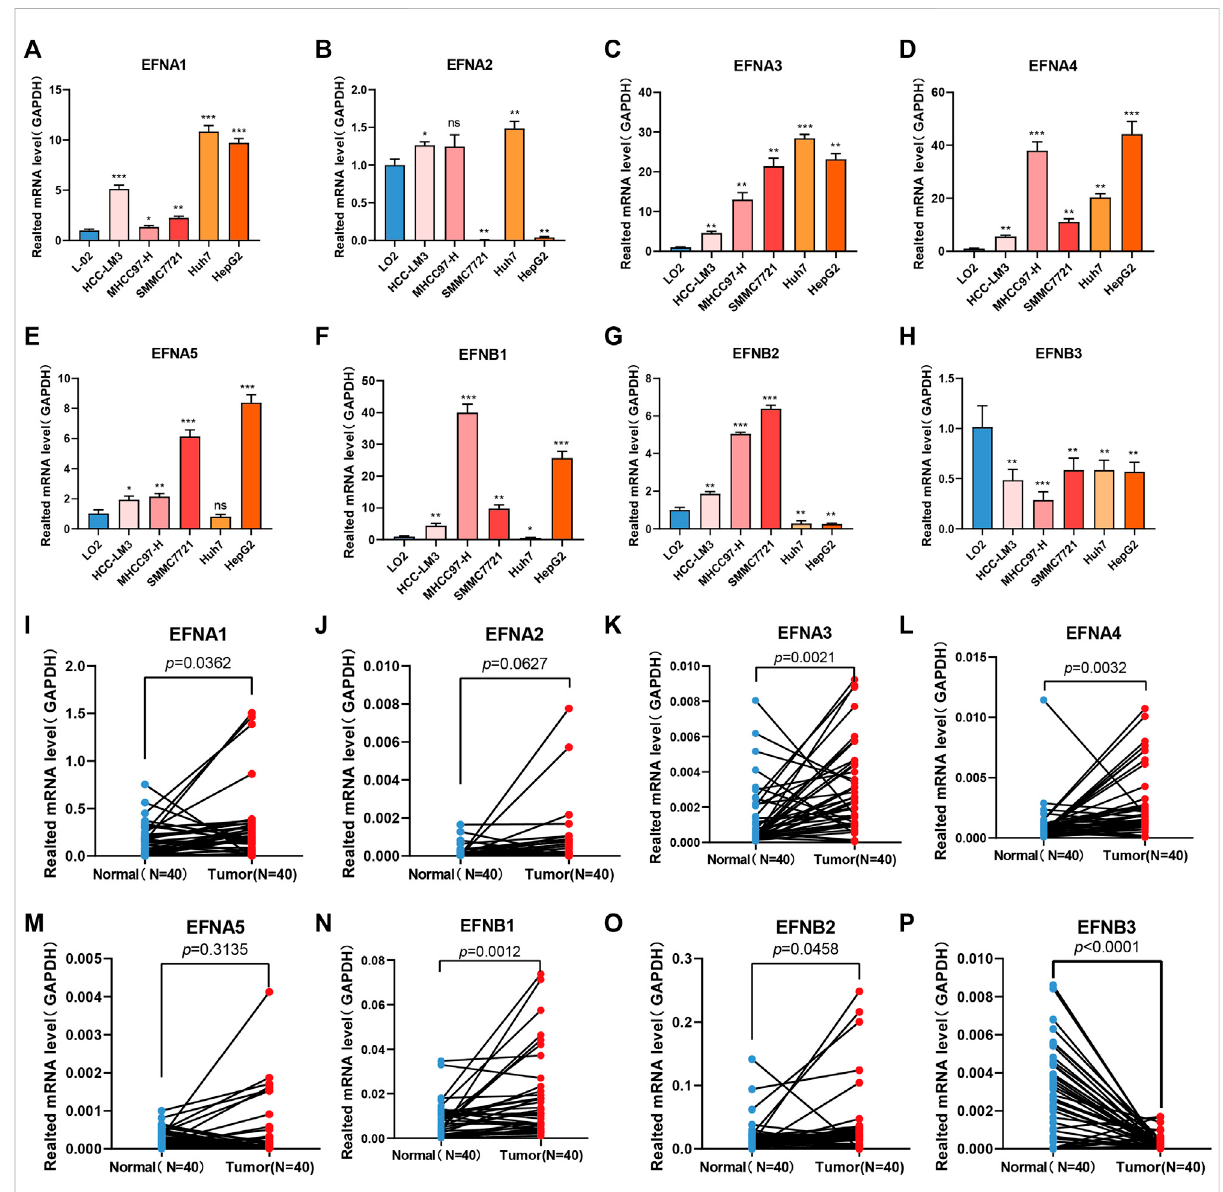
FIGURE 11 Ephrin family genes are abnormally expressed in HCC cell lines and HCC tissues. (A – H) RT – qPCR analysis of the mRNA expression of ephrin genes in fi ve HCC cell lines (HCC-LM3, MHCC97-H, SMMC 7721, Huh-7, and HepG2) and a normal liver cell line (LO2). EFNA1 (A) , EFNA2 (B) , EFNA3 (C) , EFNA4 (D) , EFNA5 (E) , EFNB1 (F) , EFNB2 (G) , and EFNB3 (H) . (I – P) The mRNA expression of ephrin genes in 40 pairs of HCC tissues and adjacent para-carcinoma tissues was evaluated using qPCR. EFNA1 (I) , EFNA1 (I) , EFNA2 (J) , EFNA3 (K) , EFNA4 (L) , EFNA5 (M) , EFNB1 (N) , EFNB2 (O) , and EFNB3 (P) . GAPDH was used as an internal control. Error bars represent the means ± SEM (triplicate experiments). * p < 0.05; ** p < 0.01; *** p <